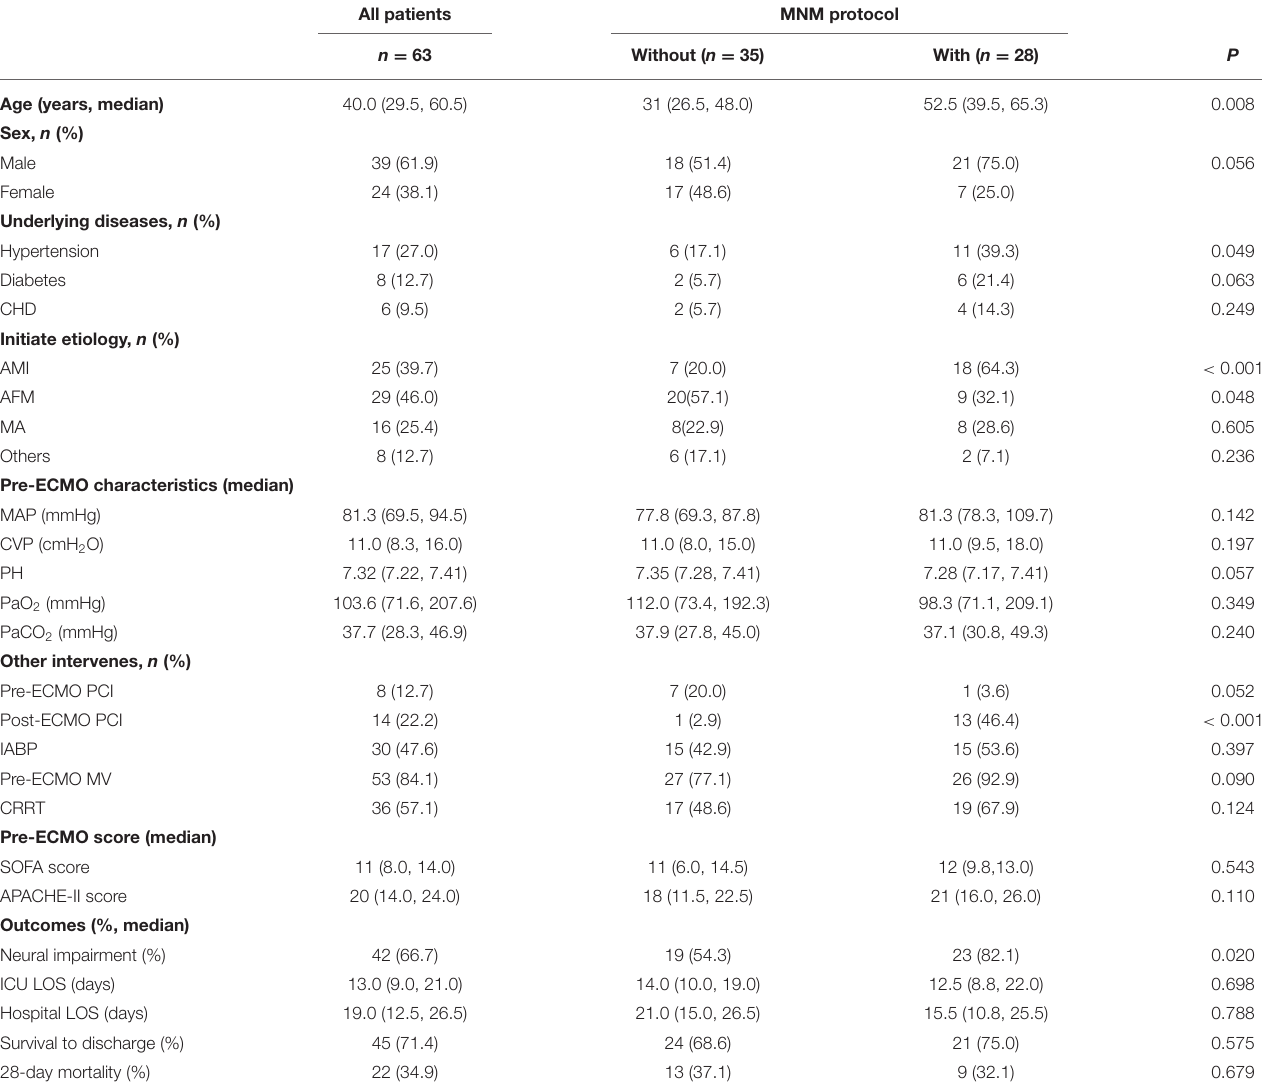
TABLE 1 | Comparison of baseline characteristics of patients.